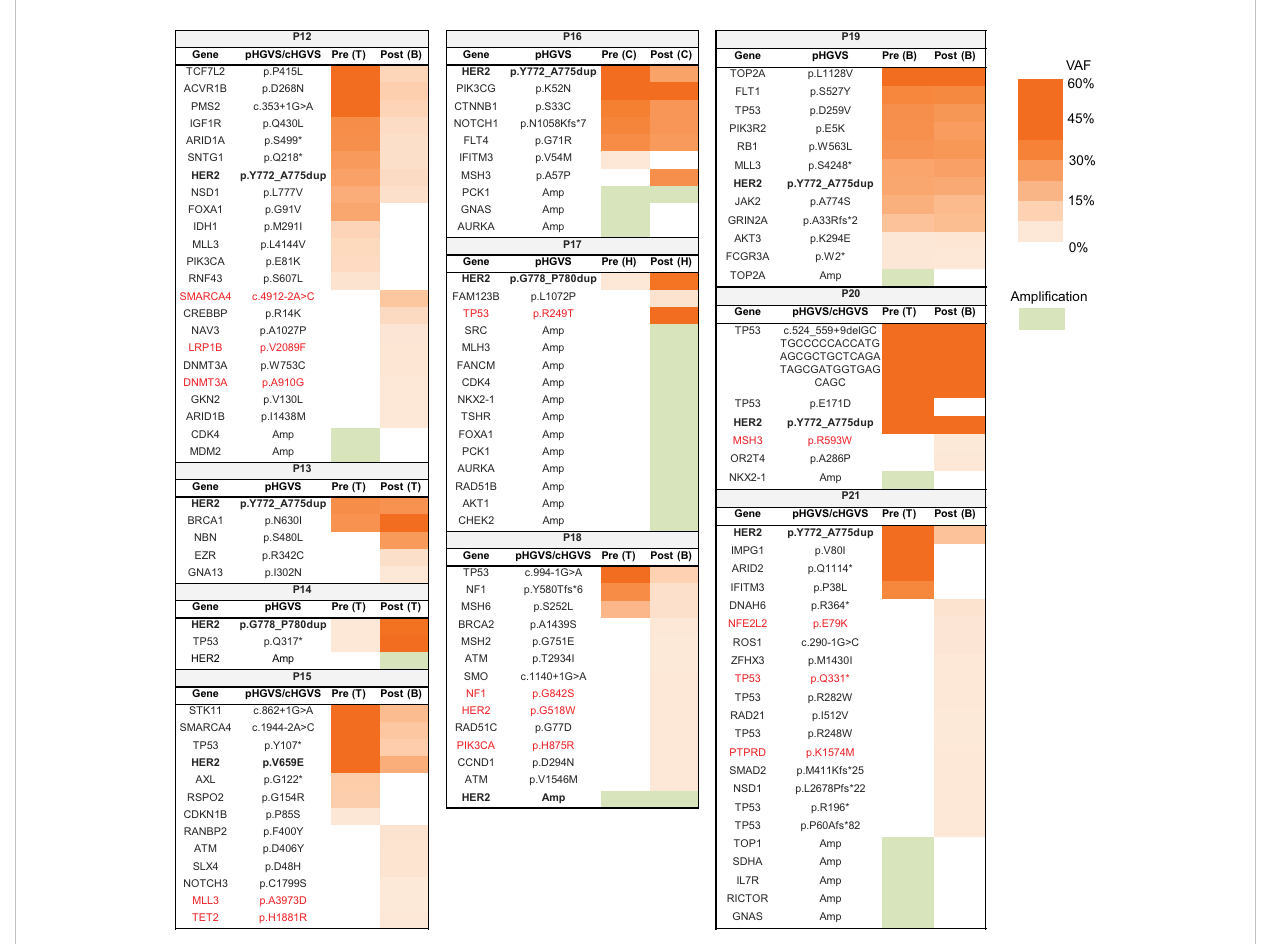
FIGURE 4 Potential resistance mechanism to afatinib and pyrotinib in lung cancer patients with HER2 alterations. Heat map showing the variants and their allele frequencies in patients with HER2 alterations before and after treatment. The acquired oncogenic mutations after treatment are marked with red color. B, blood; C, cerebrospinal fl uid; H, hydrothorax; T, tissue; VAF, variant allele